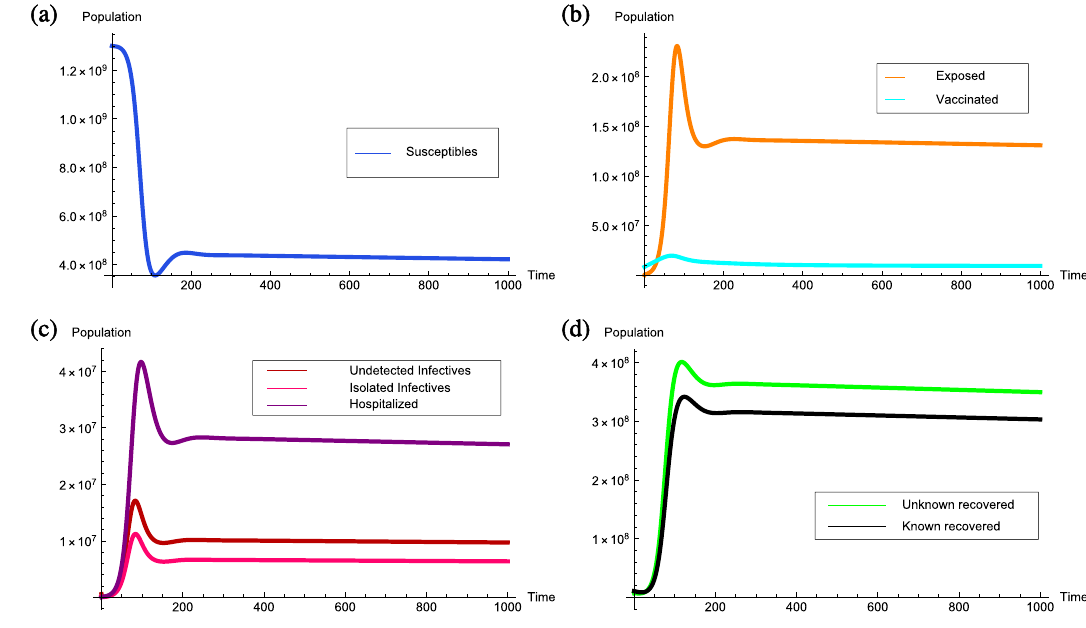
Figure 6. Graphs illustrating the COVID-19 infection prevalence together with the local stability of the endemic 8 , 5.48786 × 10 7 , 3.99376 × 10 6 , 4.06451 × 10 6 , 2.66705 × 10 6 , 1.1334 × 10 7 , equilibrium point P ∗ = ( 1.76186 × 10 1.46094 × 10 8 , 1.26657 × 10 8 ) when the corresponding reproduction number for COVID-19 is greater than unity.